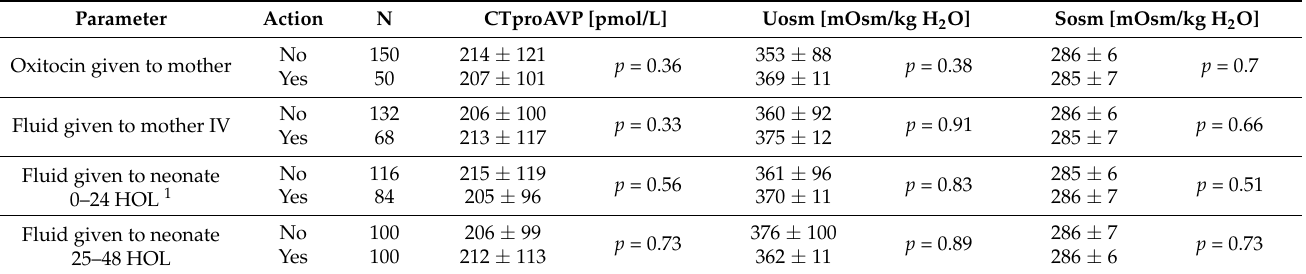
Table 2. Table: urine osmolality (Uosm), plasma effective osmolality (Sosm), CTproAVP in relation to oxytocin and fluids given intravenously to mothers or fluids given orally to neonates regardless of breastfeeding. Values presented as means ±